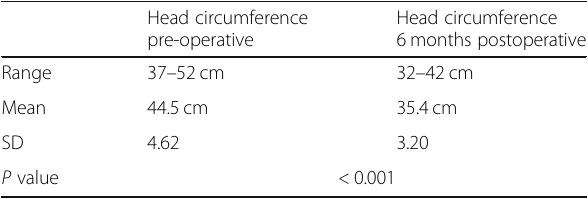
Table 2 Head circumference change after successful shunting Head circumference pre-operative